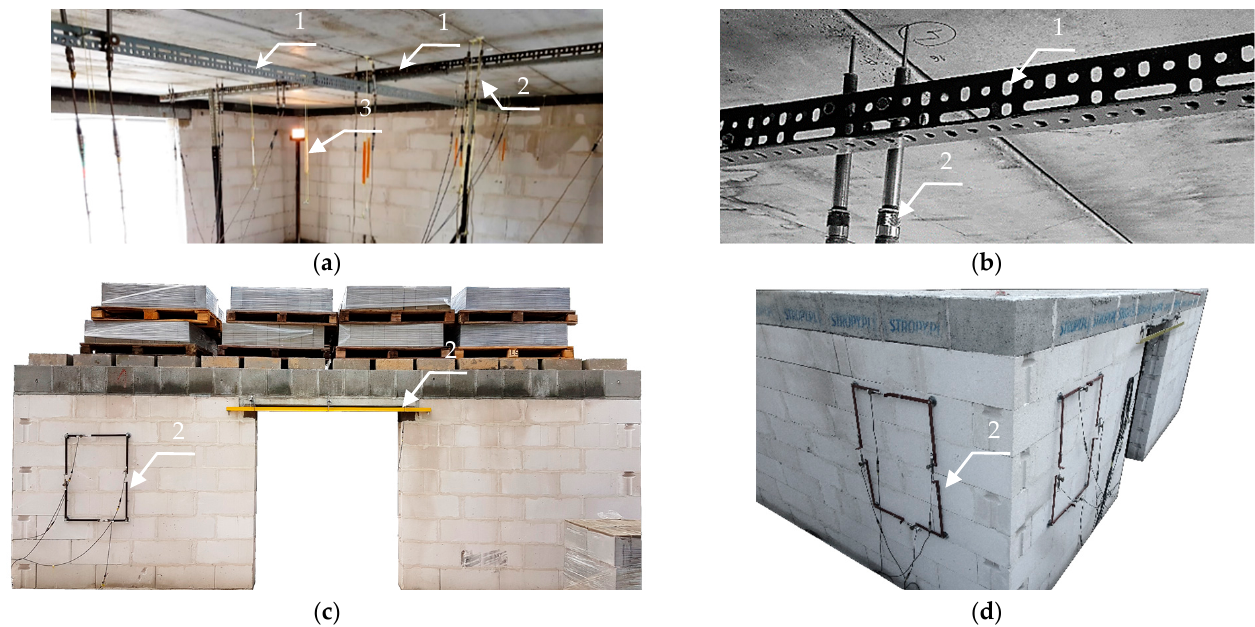
Figure 10. Overall view of sensors arrangement: ( a ) inside; ( b ) panel joint; ( c ) front view with lintel and wall measurement; ( d ) wall measurement. 1—steel frame, 2—LVDT sensor, and 3—geodetic marker.